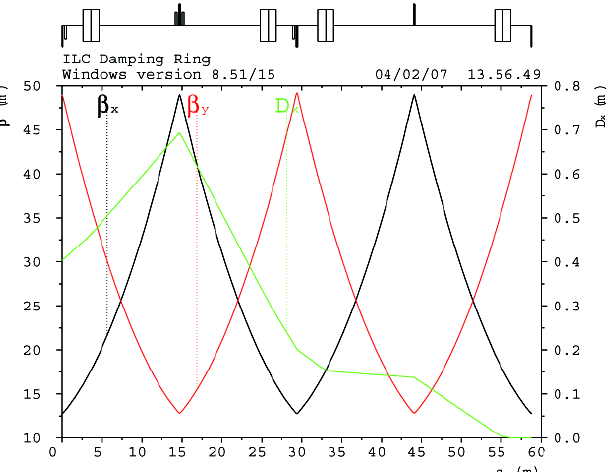
FIG. 3. (Color) Lattice functions in the 90 = 90 degree dispersion